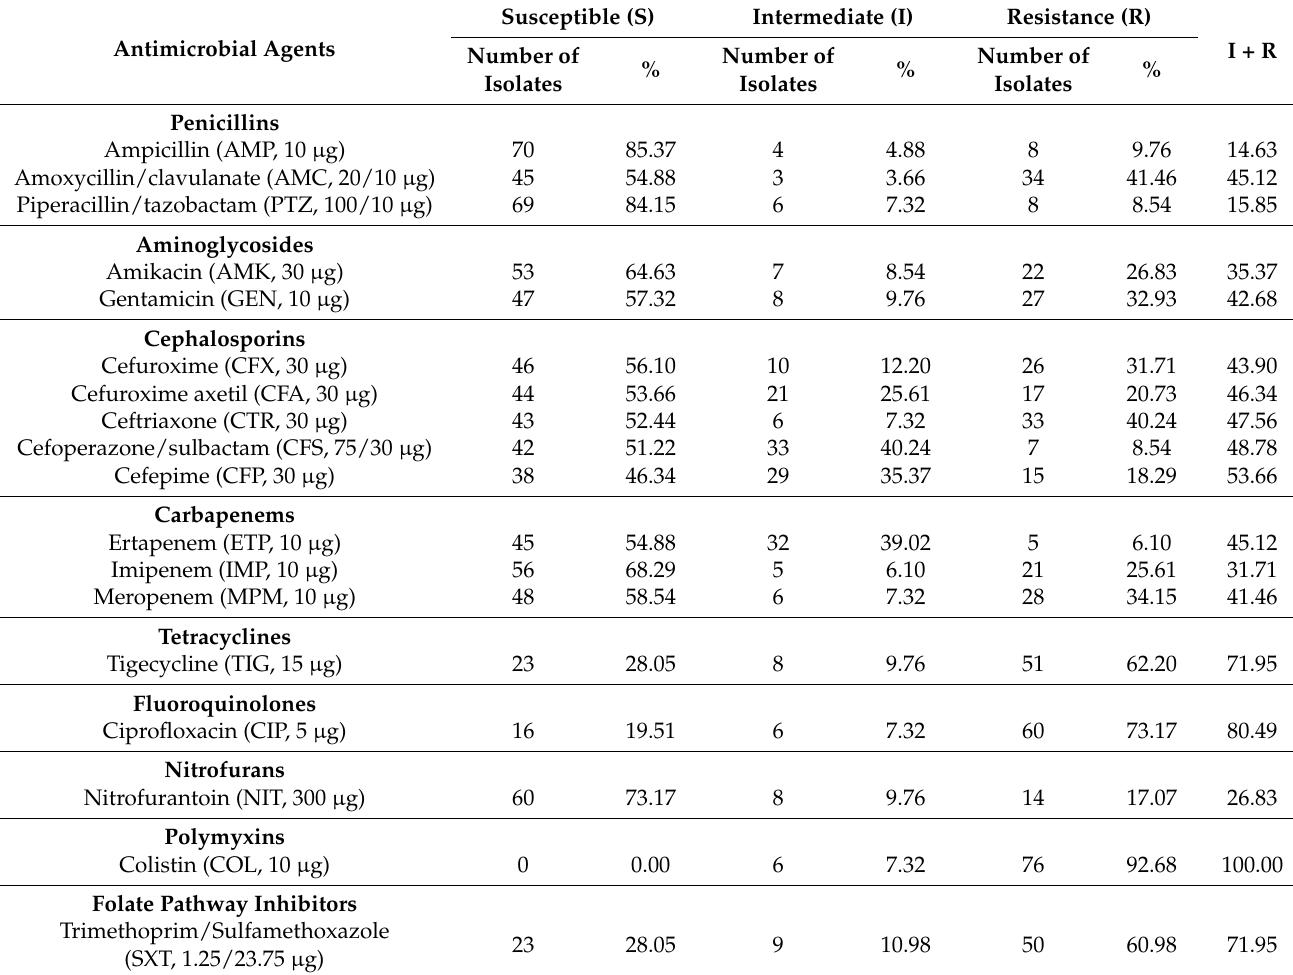
Table 2. Antimicrobial susceptibility profile of Salmonella isolates ( n = 82) in the present study. Susceptible (S) Intermediate Antimicrobial Agents